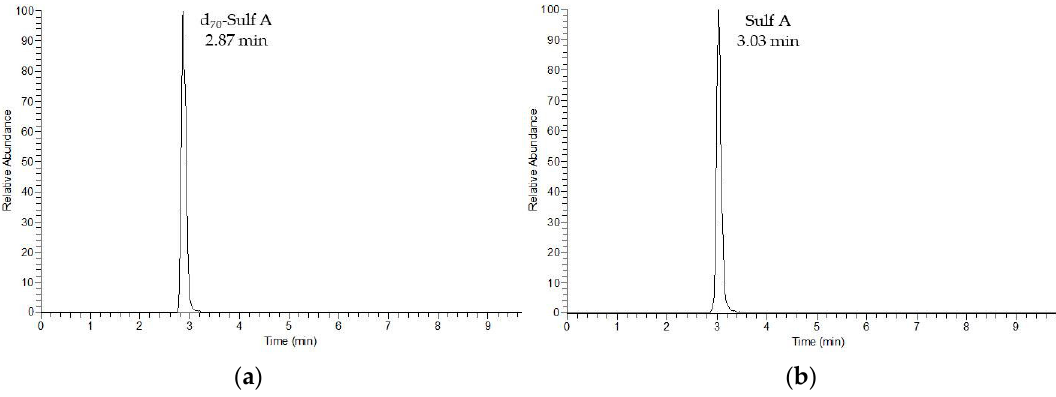
Figure 3. Chromatograms of d 70 -Sulfavant A ( a ) and Sulfavant A ( b ) as base peak extraction at m / z 920.016 and 849.576 respectively, applying a mass tolerance of 5 ppm.